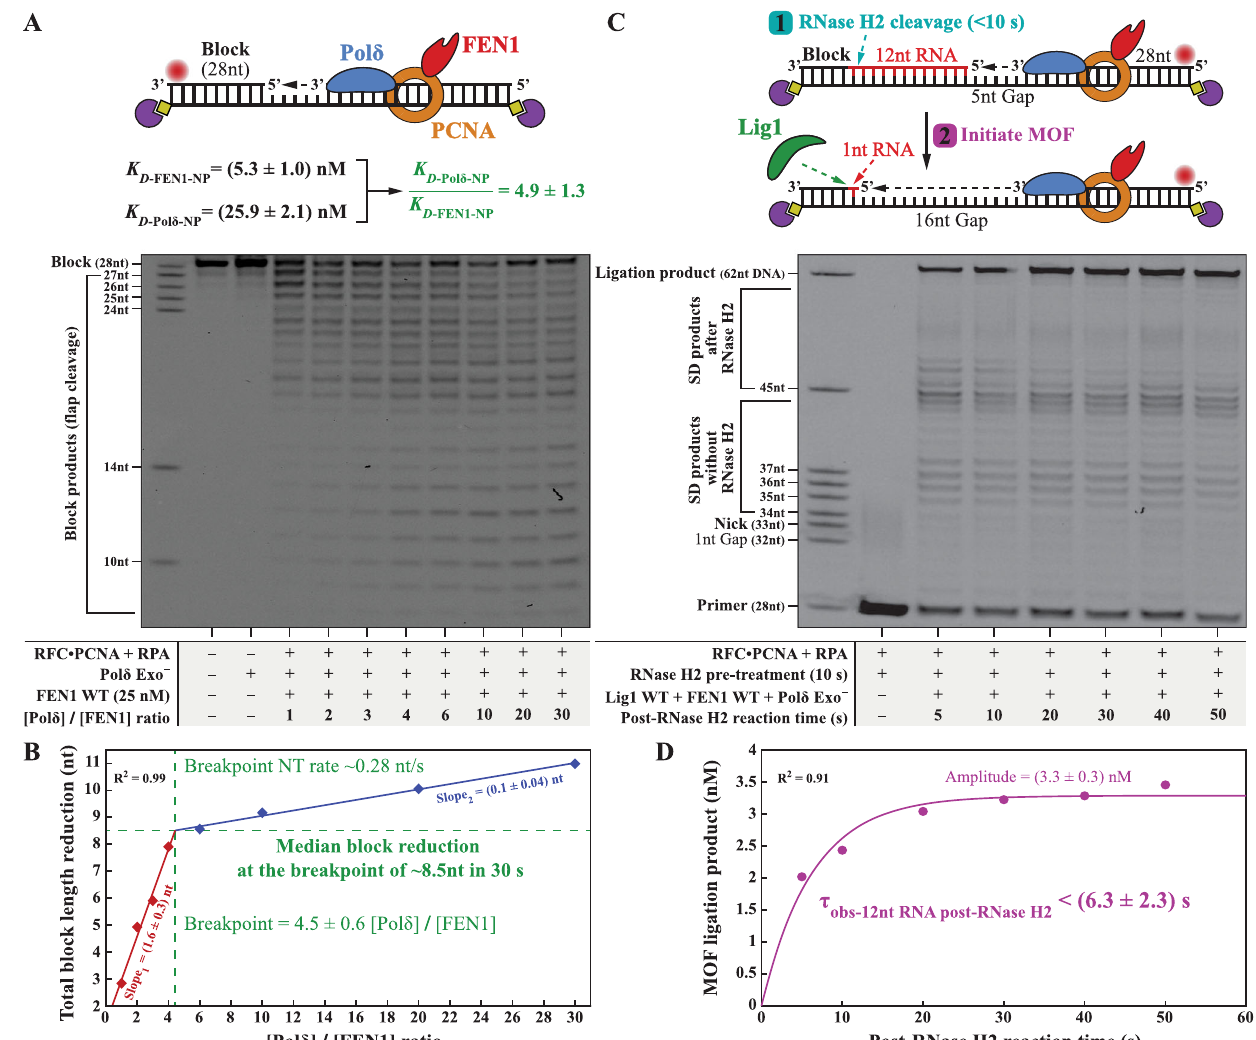
Fig. 6 | Mechanisms that accelerate human NT and MOF. A NT products mon- itoredthroughtheextensionoftheprimeroligonucleotideat fi xedFEN1andvaried Pol δ concentrations: 25nM FEN1, 37°C, 30s, DNA Sub#2 (Supplementary Fig. 7). B Quanti fi cationoftheNTreactionproductspresentedinpanel A .Medianproduct lengths beyond the fi rstNPweredetermined for each Pol δ :FEN1 ratioas described intheMethodssection.Theexperimentaldatapointswere fi ttedtoacontinuousbi- lineardependencywithavariablebreakpoint.Thebreakpointratewasdetermined by dividing the totalblock length reduction atthe breakpoint (~8.5 nt) by 30s. The intercept of the model was determined from the fi t as 1.3±0.5 nt, probably